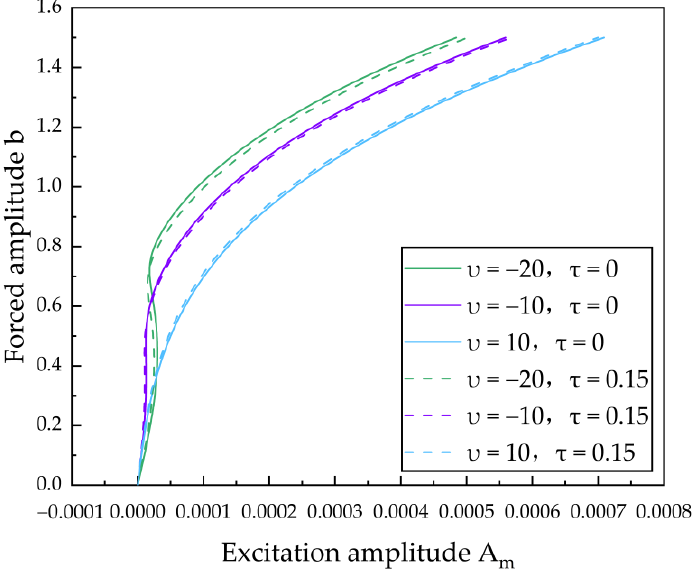
Figure 5. Forced amplitude versus excitation amplitude with different detuning parameters. 0 . 1 and